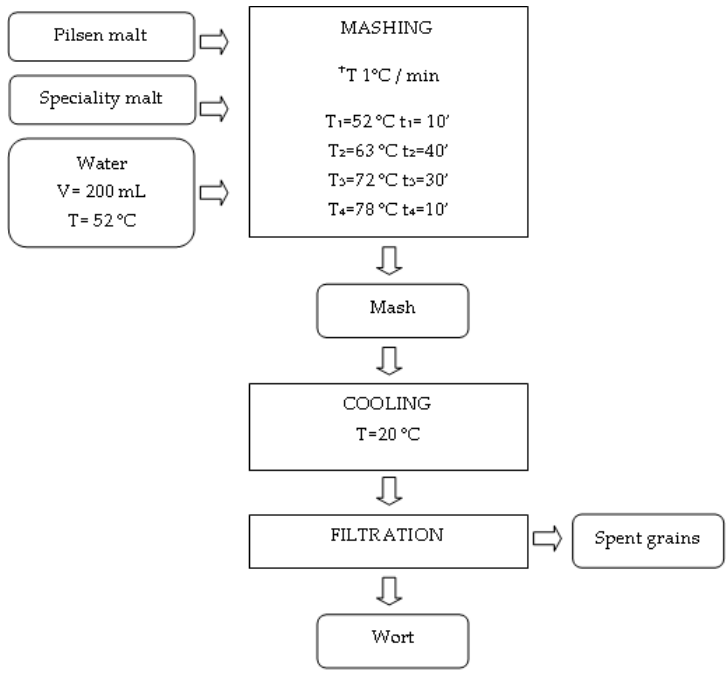
Figure 4. Technological process of producing wort.